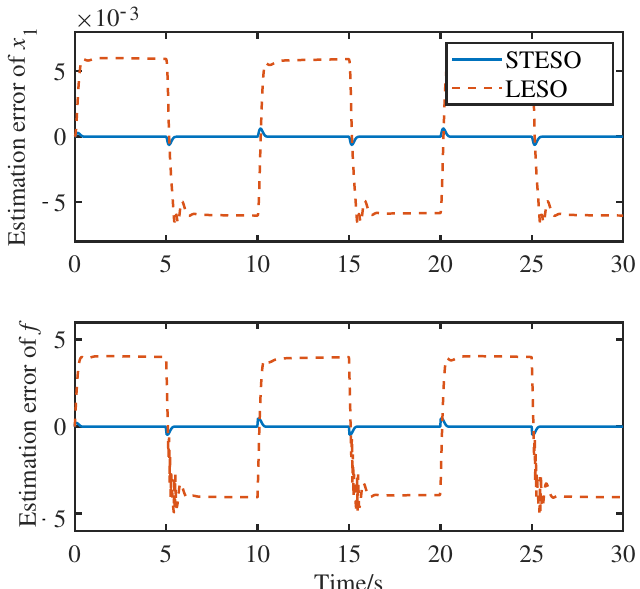
Figure 6. Simulation resultsof multiple disturbance—estimation error: STESO (solid line); LESO (dashed